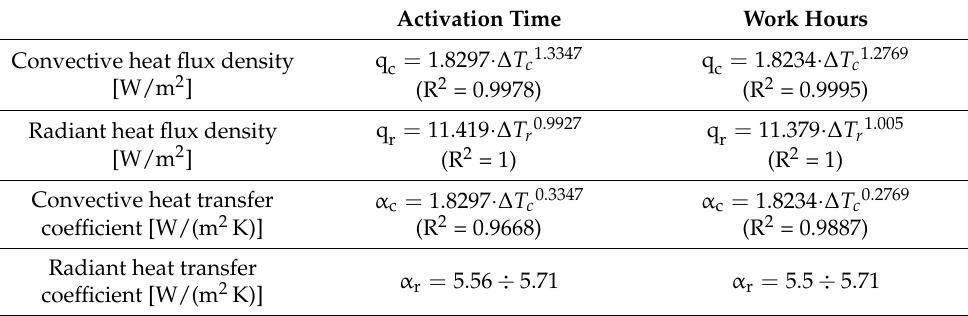
Table 3. Equations proposed for the calculation of heat flux density and heat transfer coefficient.